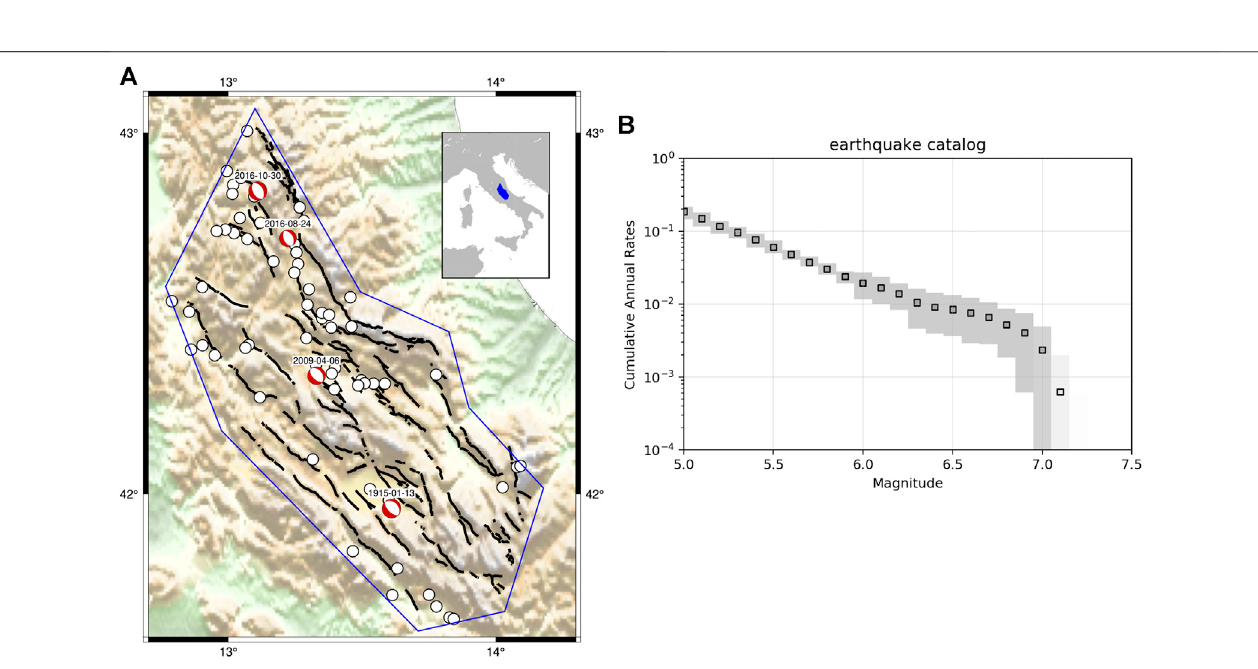
FIGURE 2 | (A) The study region of the Fault2SHA Central Apennines laboratory. White circles are Mw fi ve and above earthquakes extracted from the CPTI15 earthquake catalogue, solid black lines are the traces of active normal faults extracted from the Fault2SHA CAD, and focal mechanism are for the Mw six and above earthquakes occurred in the last century. (B) Earthquake rates based on the CPTI15 and the completeness periods ofMeletti et al. (2019) reported in Table 1 . The grey patchesarethe16thand84thpercentilesofthedistributionfortheratescomputedfromindividualMonteCarlosamplesaccountingforuncertaintiesinearthquake magnitude and completeness